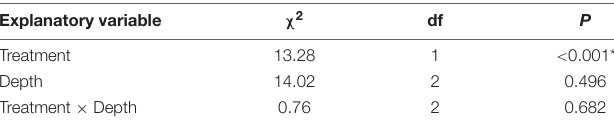
TABLE 1 | Analysis of deviance for beta regression model relating substrate moisture to treatment (mussel-removal vs. control benches) and depth layer (0–5, 5–10, and 10–15 mm).